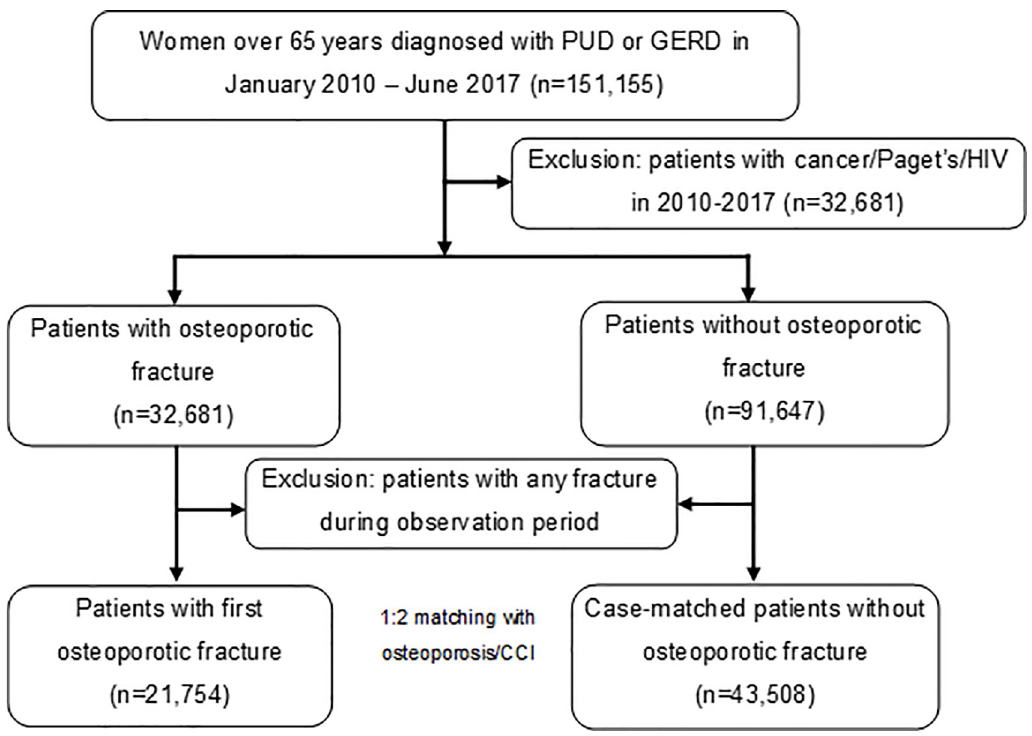
Fig 1. Flowchart of case and control selection. PUD: Peptic ulcer disease, GERD: gastroesophageal reflux disease, HIV: human immunodeficiency virus; CCI, Charlson comorbidity index.